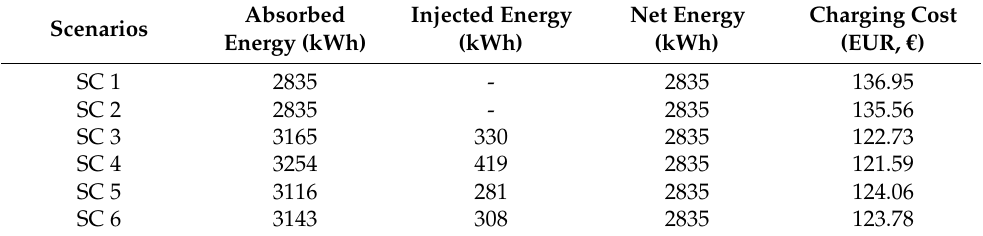
Table 4. Absorbed, injected and net energy of the PL for all operation scenarios.